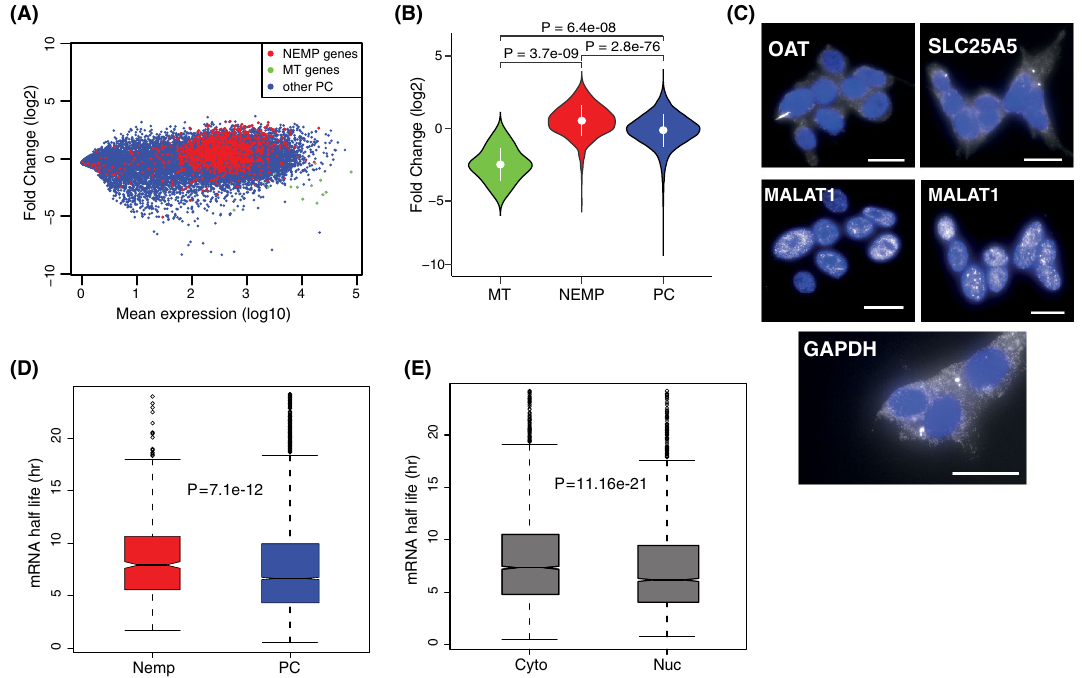
Figure 2. Nuclear-encoded-mitochondrial proteins (NEMPS) are significantly enriched in the cytosol. (A) MA plot showing localization distribution of NEMPs (red), remaining protein-coding genes (blue), and mitochondrial encoded genes (green). (B) Violin plot showing fold change distributions between the three gene categories (baseMean ≥ 10) in cytosolic and nuclear fractions. P-values reported were obtained with the Mann– Whitney–Wilcoxon test. (C) Validation of the enrichment of NEMPs RNA transcripts OAT and SLC25A5 in the cytosol in SHSY-5Y cells using RNA FISH. MALAT1 (known nuclear transcript) and GAPDH used for comparison. Images represent maximum projections of 13, 18, 20 optical intervals spaced by 0.5 μm. Scale bar, 2 μm. (D) Box plot shows mRNA half-life rate comparison between groups of differentially localized NEMP (red) and remaining protein-coding genes (blue). (E) Comparison of mRNA half-life rate between cytosolic and nuclear